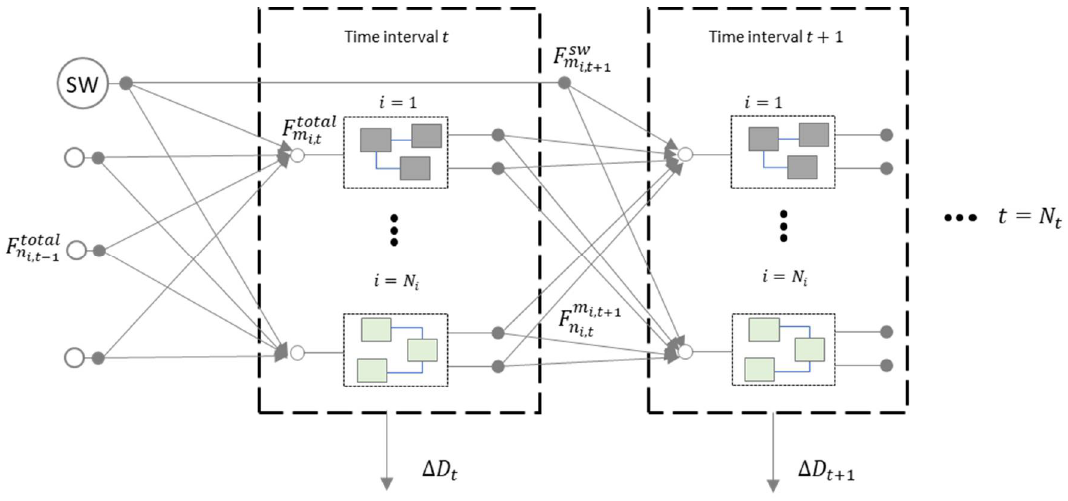
Figure 2. Multiperiod superstructure of the desalination capacity planning problem.